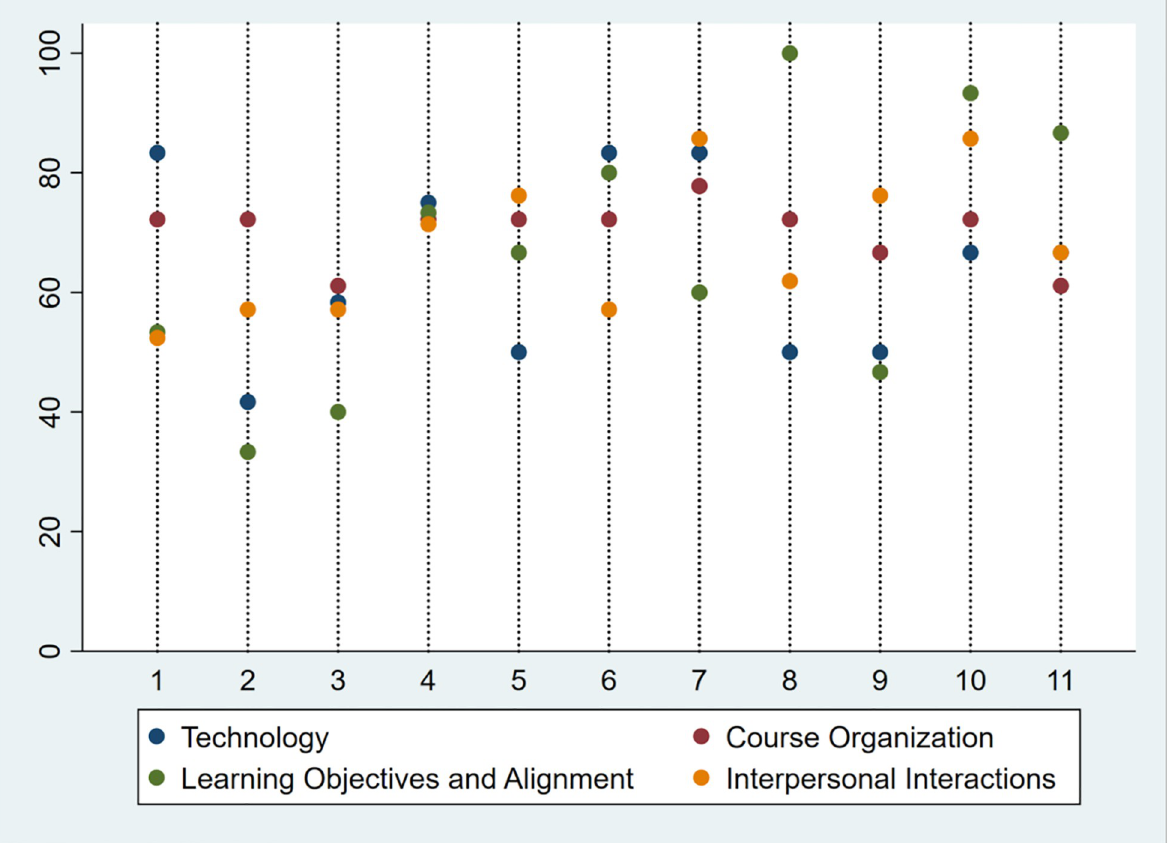
Fig 1. Ratings of the design characteristics by course. Please note that in a few cases, multiple categories have identical scores leading to obscured data points. In such cases, please consult the raw data in the appendix (S2 Table).